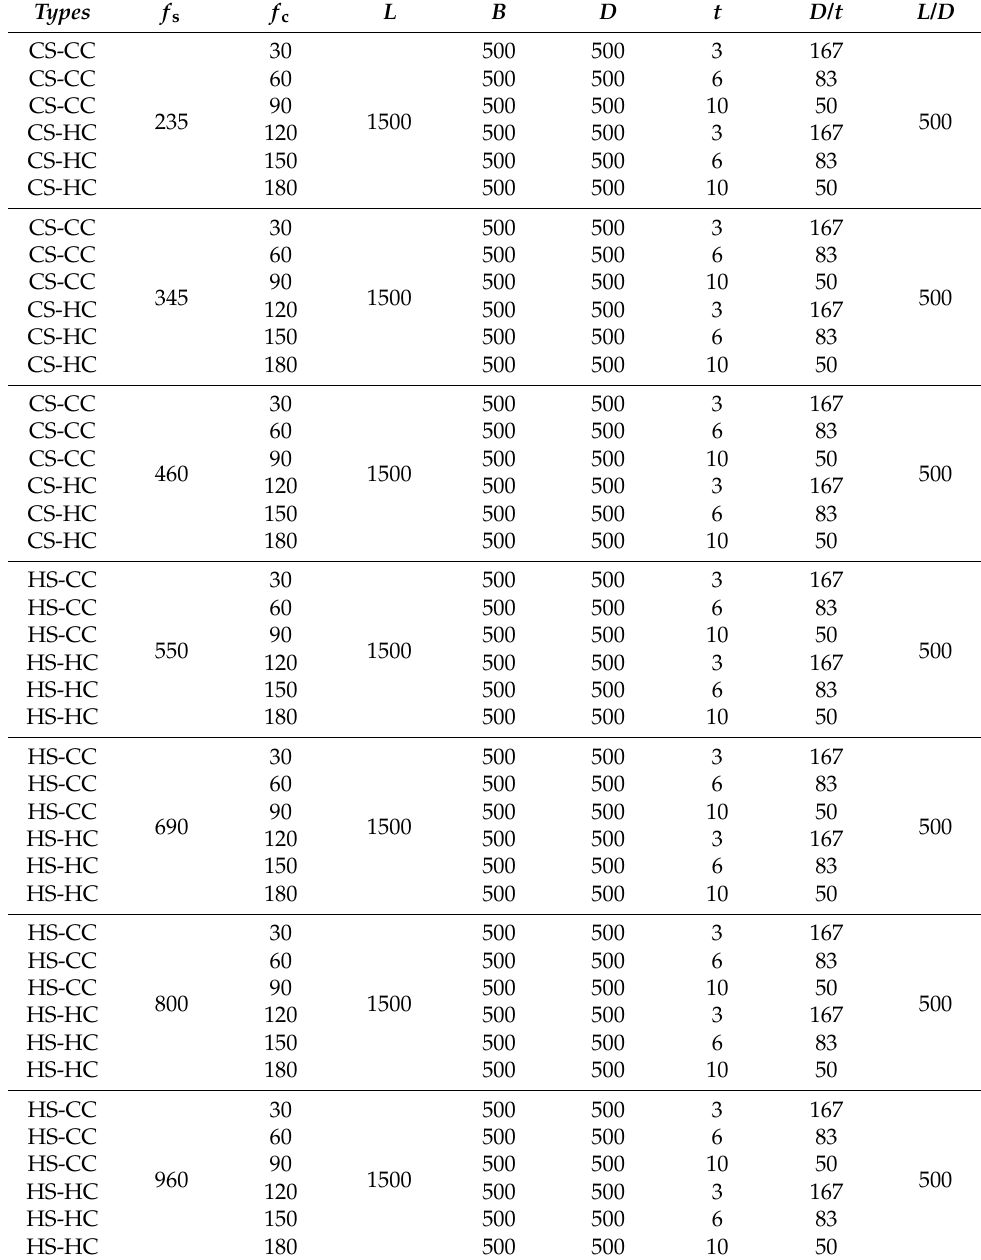
Table 1. Model parameter matching